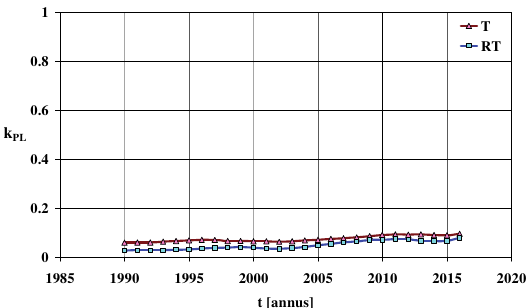
Fig. 9. Share of annual emission in Poland comparing to the annual emission in the European Union for nitrogen oxides: for total emission – T and for emission from motor vehicles – RT in years 1990–2016